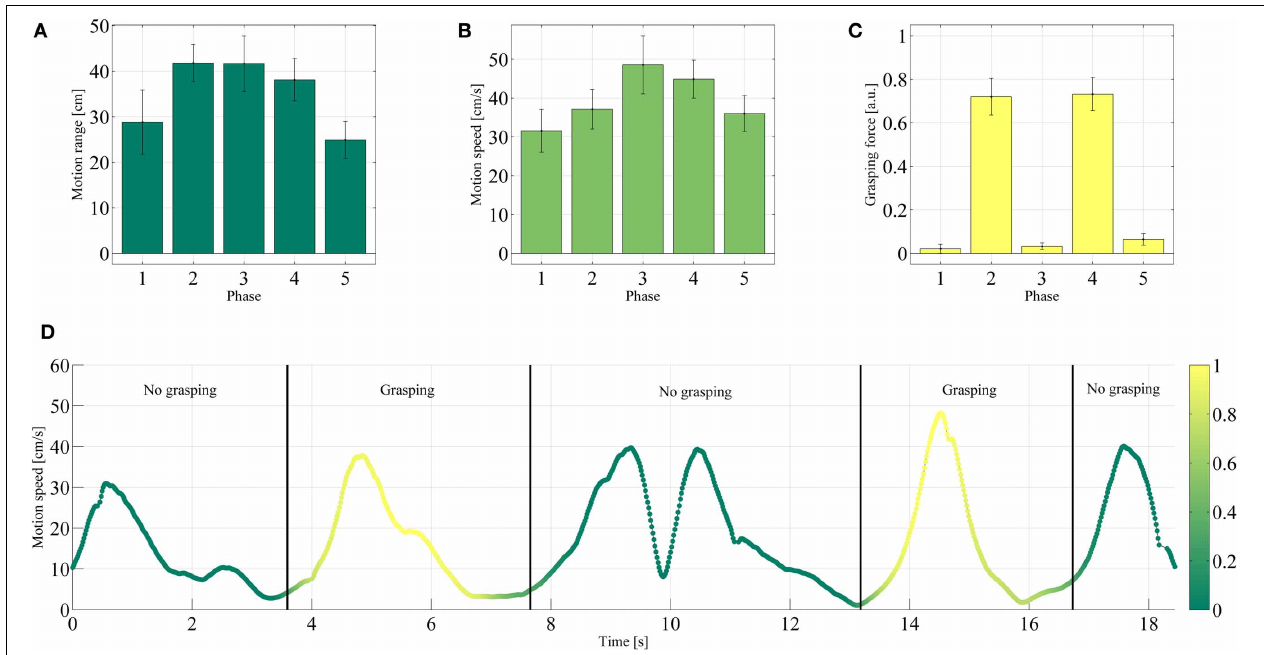
FIGURE 9 | Comparison of the end-effector motion range (A), motion speed (B), and grasping force (C) of the end effector during each phase of Task 1. The mean values and one standard deviation are reported over the